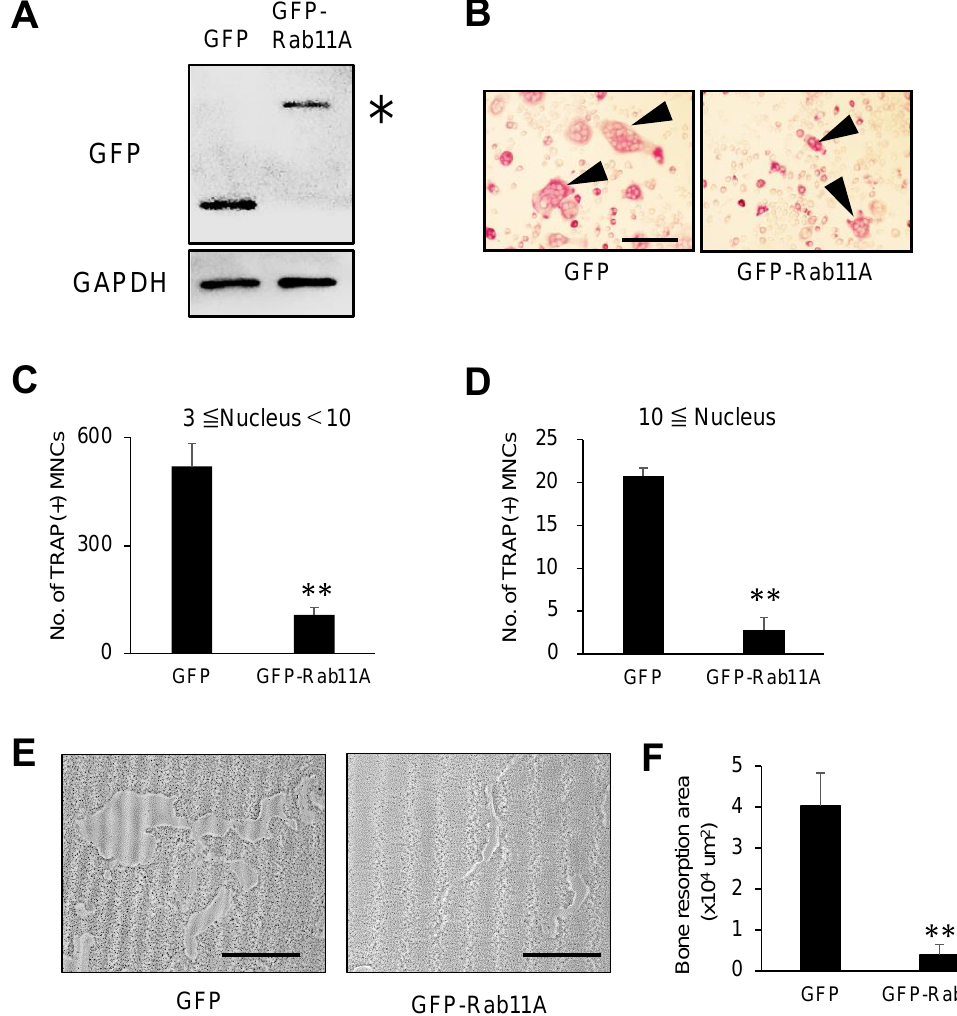
Figure 4. The effect of Rab11A overexpression on osteoclastogenesis. ( A ) GFP or GFP-Rab11A expression was determined in RAW-D cells transduced with either retrovirus vector encoding GFP or GFP-tagged Rab11A (GFP-Rab11A). An “asterisk” indicated the GFP-Rab11A band. ( B ) TRAP staining of GFP and GFP-Rab11A-expressing osteoclasts derived from RAW-D cells. Arrowheads showed mature osteoclasts. Scale bars: 200 µ m. ( C , D ) The number of TRAP-positive multinucleated osteoclasts with 3–10 nuclei or more than 10 nuclei per viewing field was counted. ** p < 0.01. ( E ) Images of the bone resorption area of RAW-D-derived osteoclasts expressing GFP-alone or GFP- Rab11A. Scale bars: 100 µ m. ( F ) The resorption area was determined using Image J software. The data are represented as mean ± SD of values from three independent experiments.